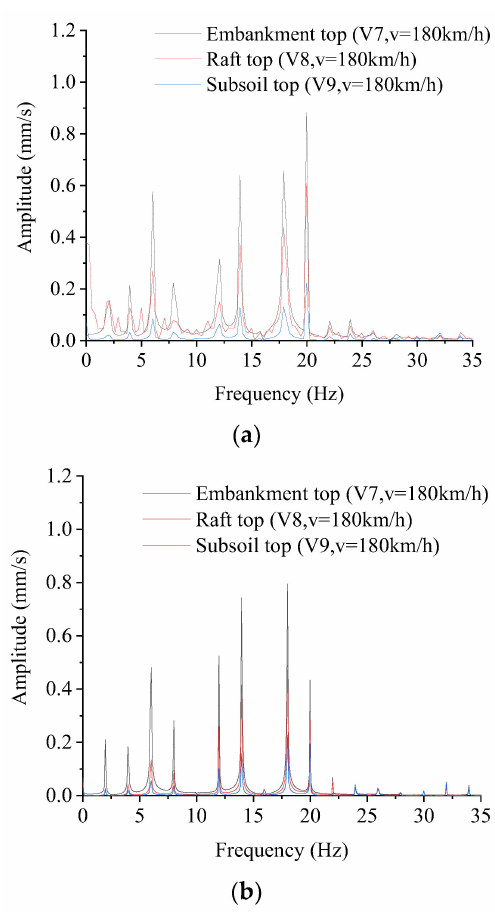
Figure 11. Frequency contents of vibration velocities at embankment top V7, raft top V8, and subsoil top V9. ( a ) Low water level, ( b ) High water level, v = 180